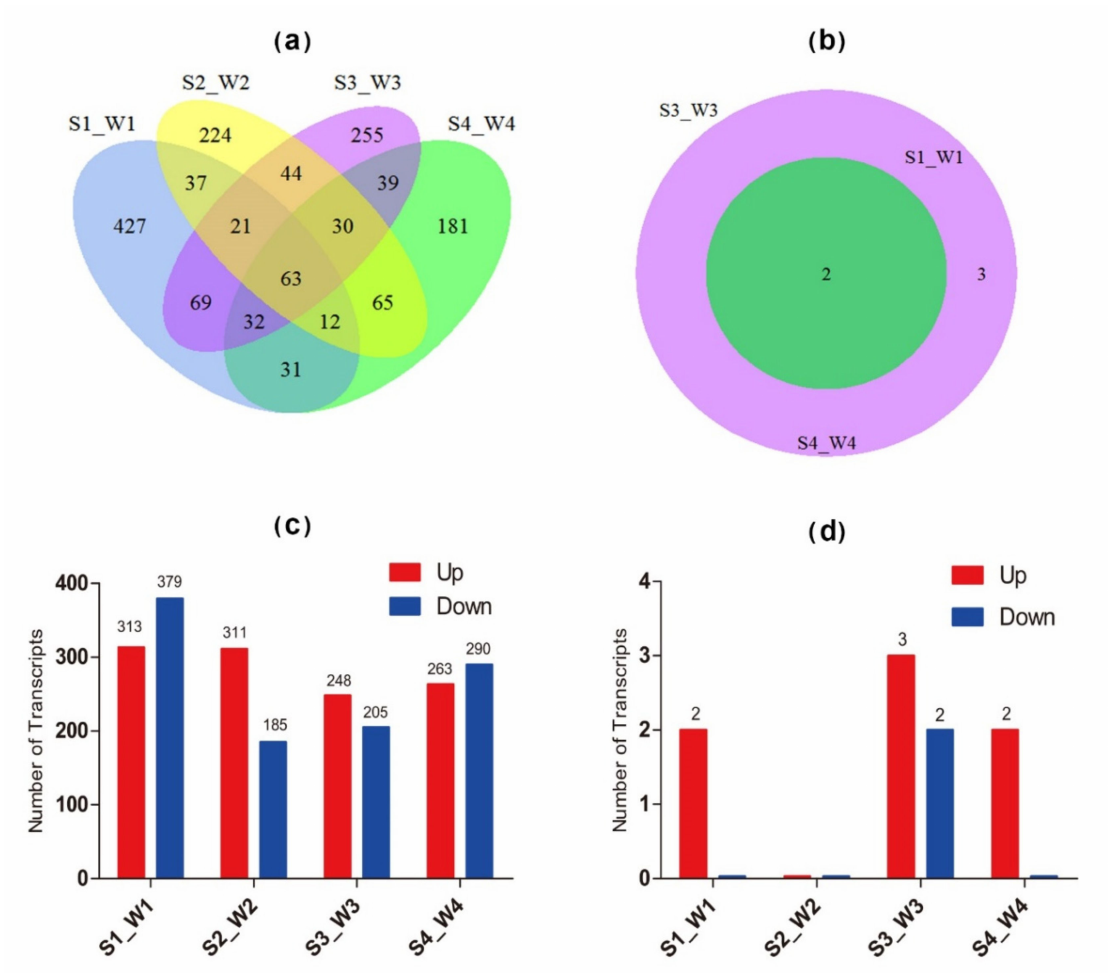
Figure 6. Number of stress-related di ff erentially expressed genes (DEGs) in Populus . ( a ) Veen diagram analysis of DEGs of Populus in response to salt stress. ( b ) Veen diagram of DEGs of the NAC transcription factor (TF) family of Populus in response to salt stress. ( c ) Up / down-regulated DEGs of Populus in response to salt stress. ( d ) Up / down-regulated DEGs of the NAC TF family of Populus in response to salt stress. S1, S2, S3 and S4 were treated with NaCl. W1, W2, W3 and W4 were controls treated with regular